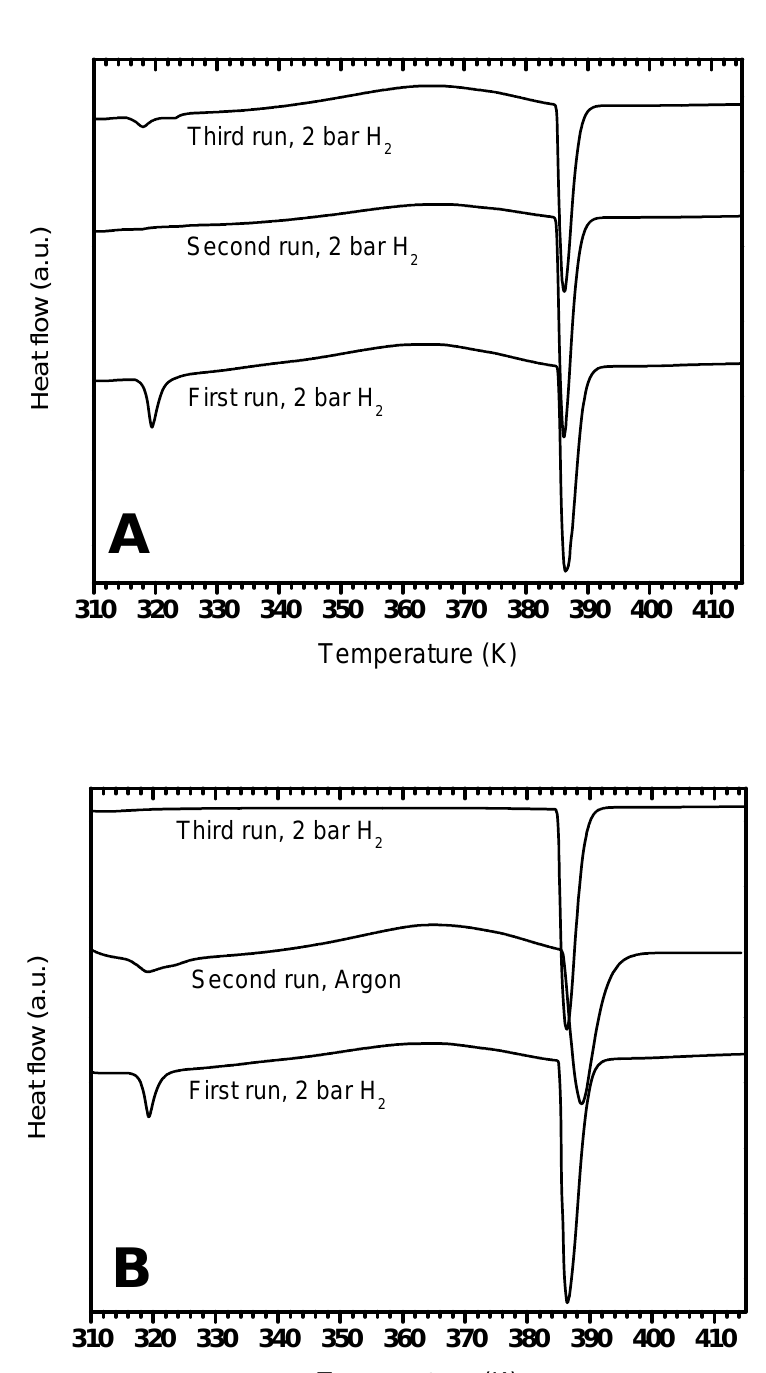
Figure 3. Successive scanning PDSC traces of unmilled LiBH under 2 bar of hydrogen pressure. (B): First run and third run under 2 bar of hydrogen, second run under argon. Heating and cooling rates: 20 K min –1